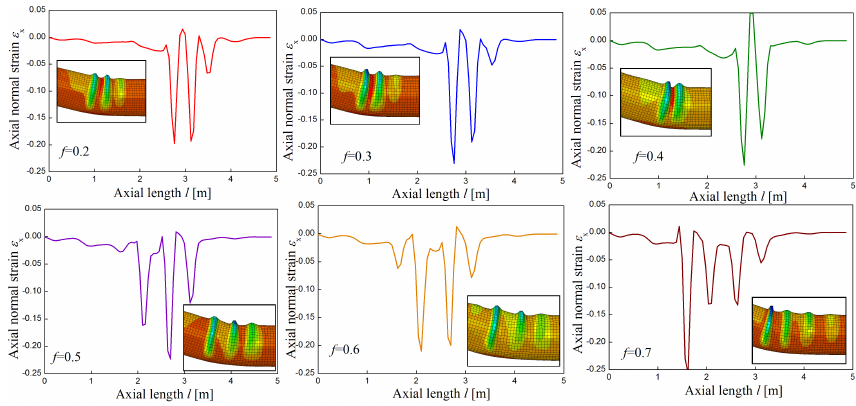
Figure 13. Variations of axial strain at the compression side of the buckling area under different friction coefficients.